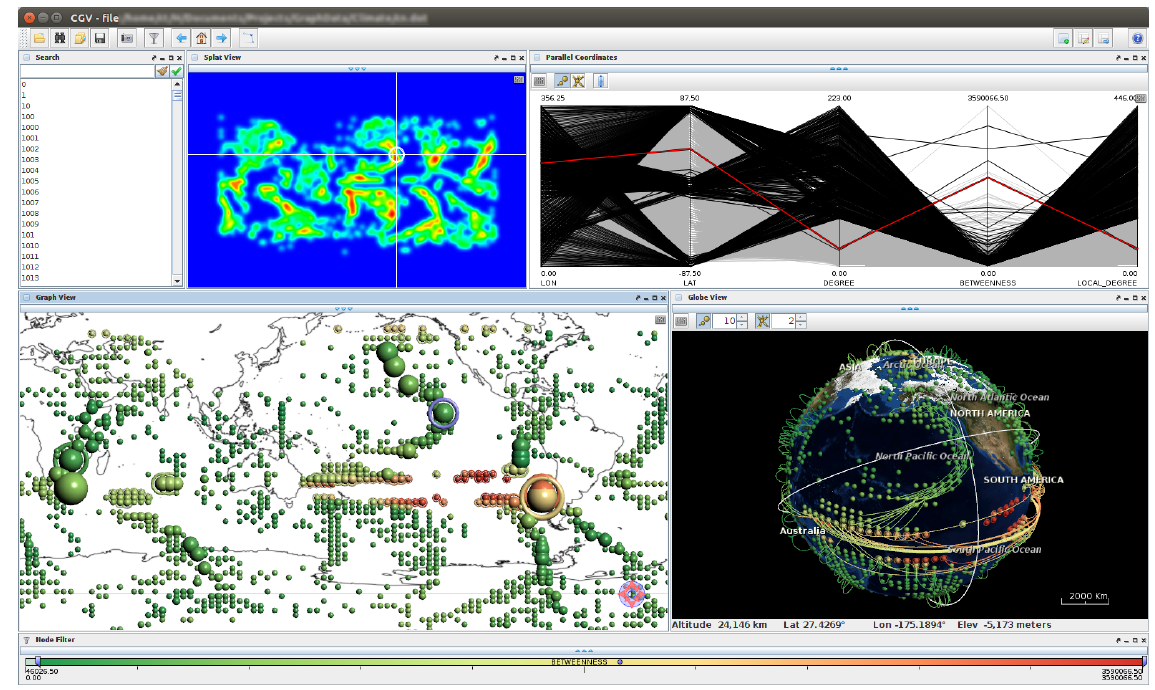
Figure 13. CGV visualises climate networks in multiple coordinated views and provides advanced